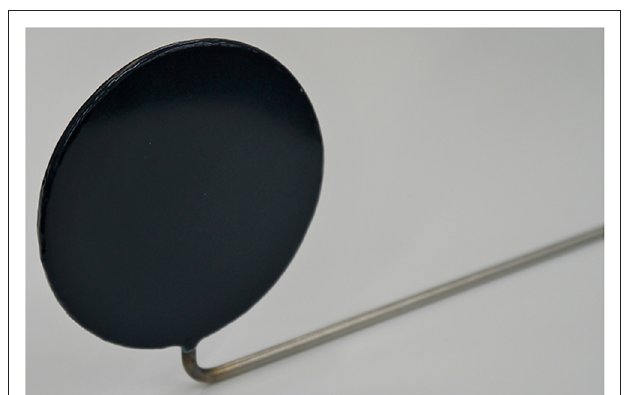
actuator individually, as shown in section Analytical Approach.